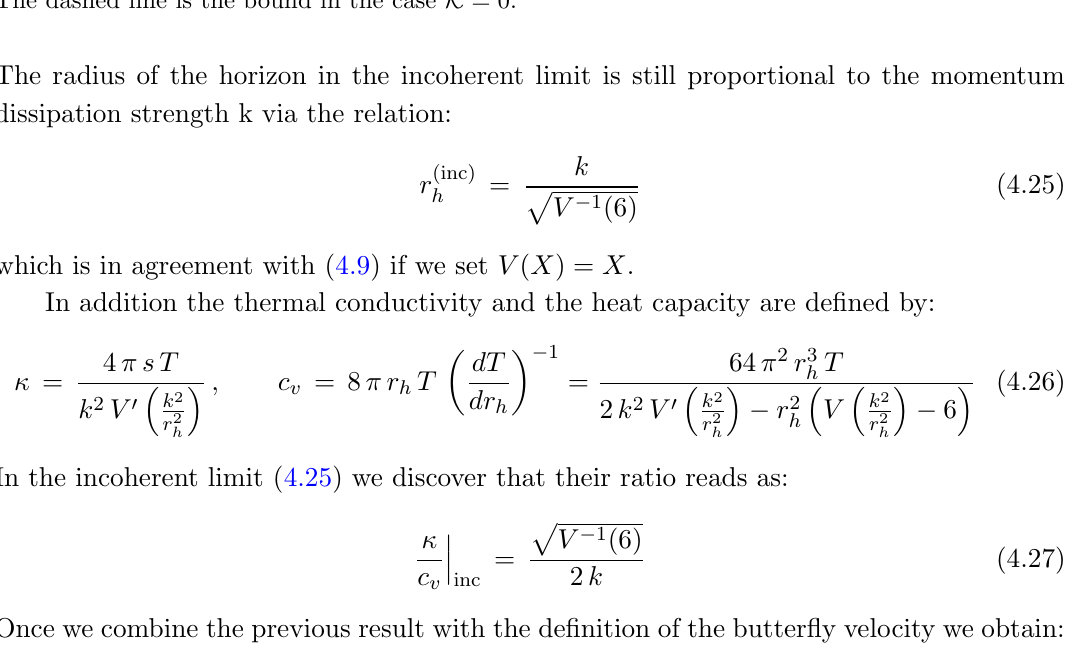
Figure 2 . Incoherent limit of D c T in function of the K parameter for the choice U ( X ) = 1 + K X . v 2 B The dashed line is the bound in the case K =